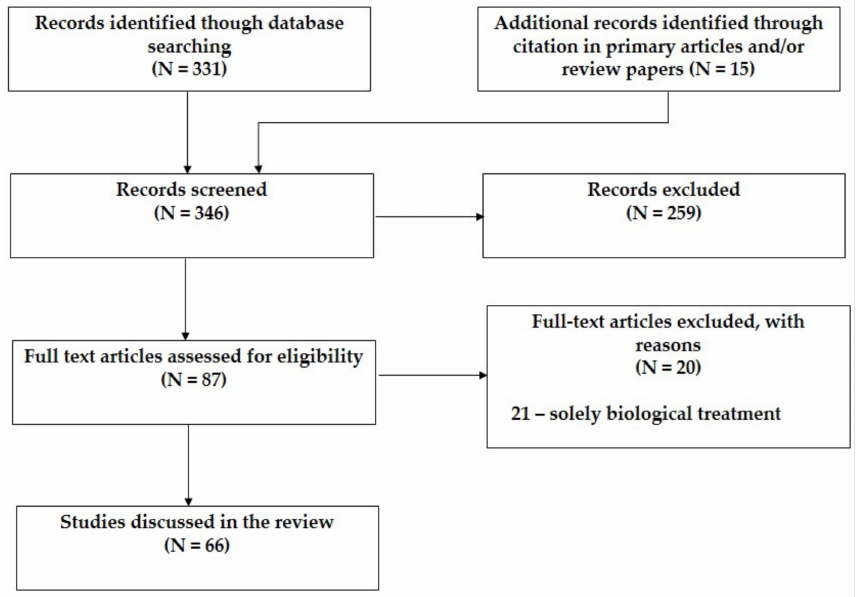
Figure 1. PRISMA flow diagram of the study selection